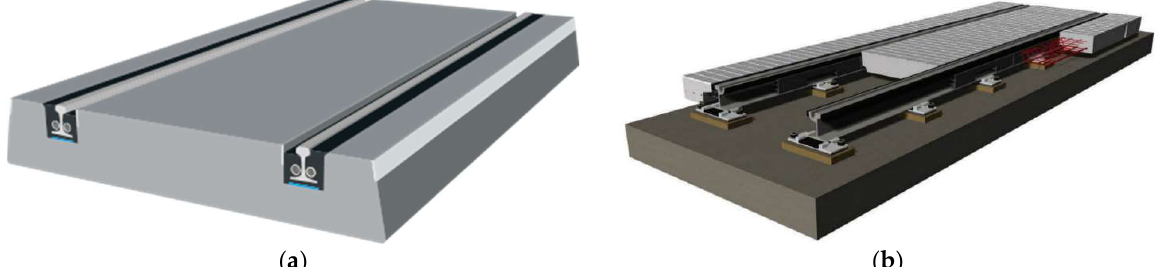
Figure 1. Tracks with ( a ) continuously fastened rails (embedded rail) and ( b ) with discretely fas- tened